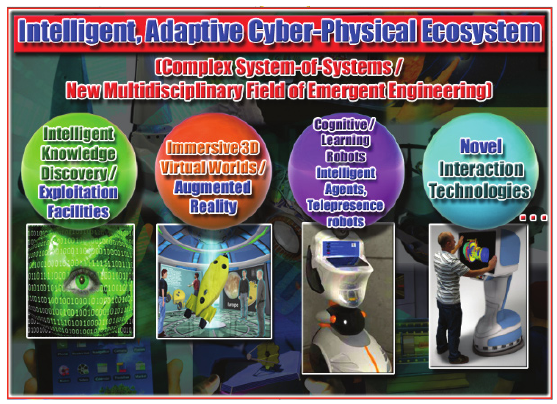
Figure 3. Major components of Intelligent Adaptive Cyber-Physical